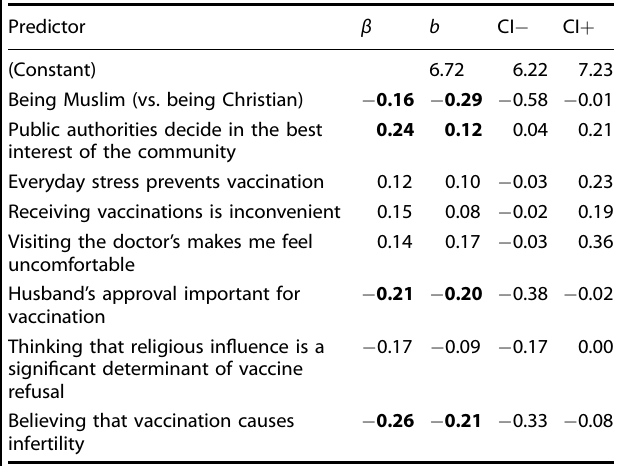
Table 1. Descriptive of 5C + at T1 and T2. Table 2. Regression results